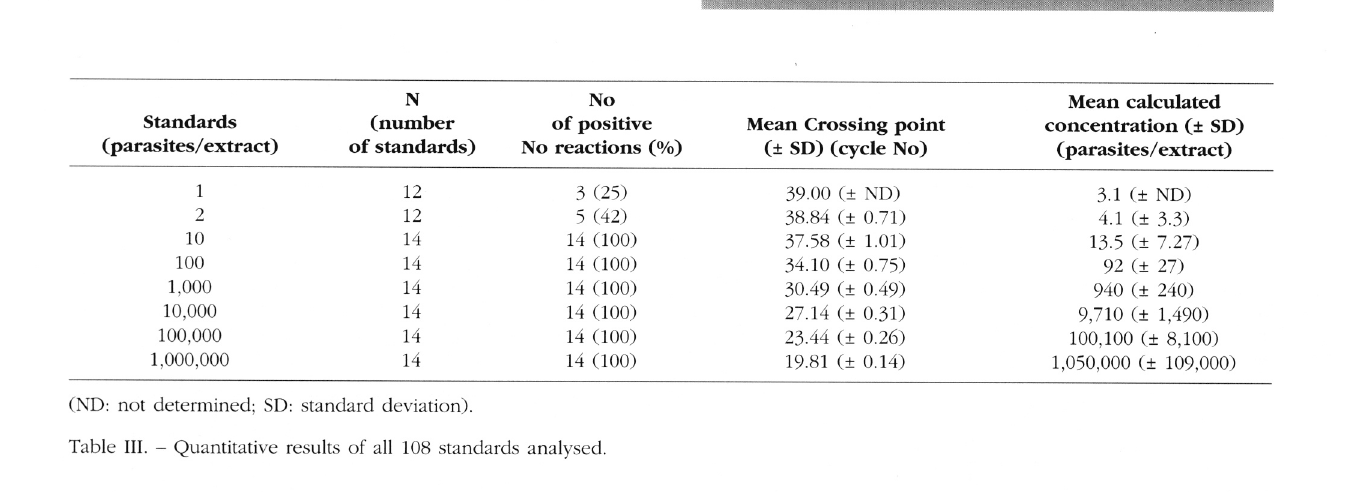
Table III. - Quantitative results of all 108 standards analysed.